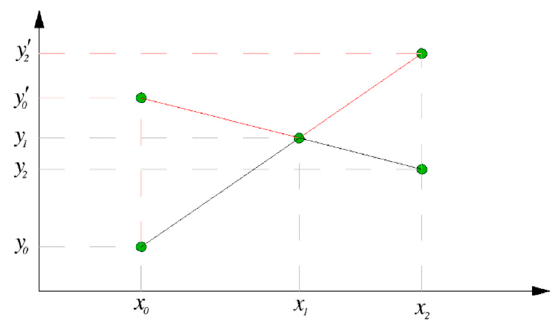
Figure 5. Extended line segments from Lagrangian form.